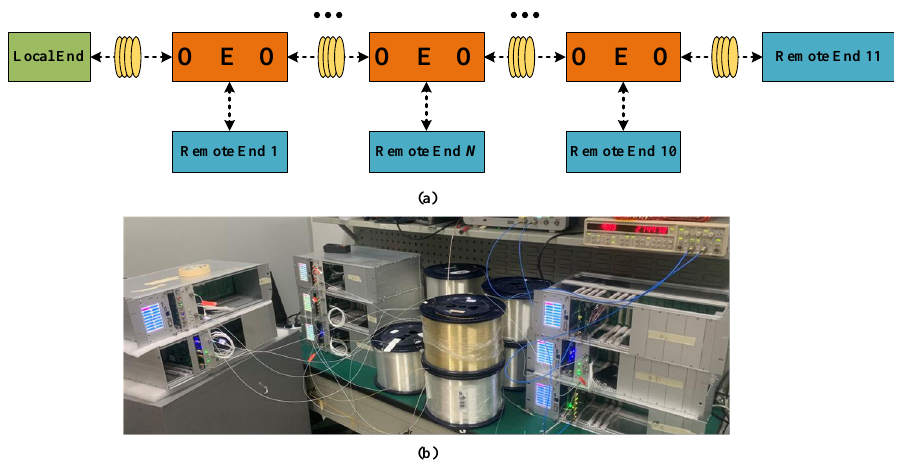
Figure 5. ( a ) Configuration of the fiber-optic link used in the experiment. ( b ) The experimental bench